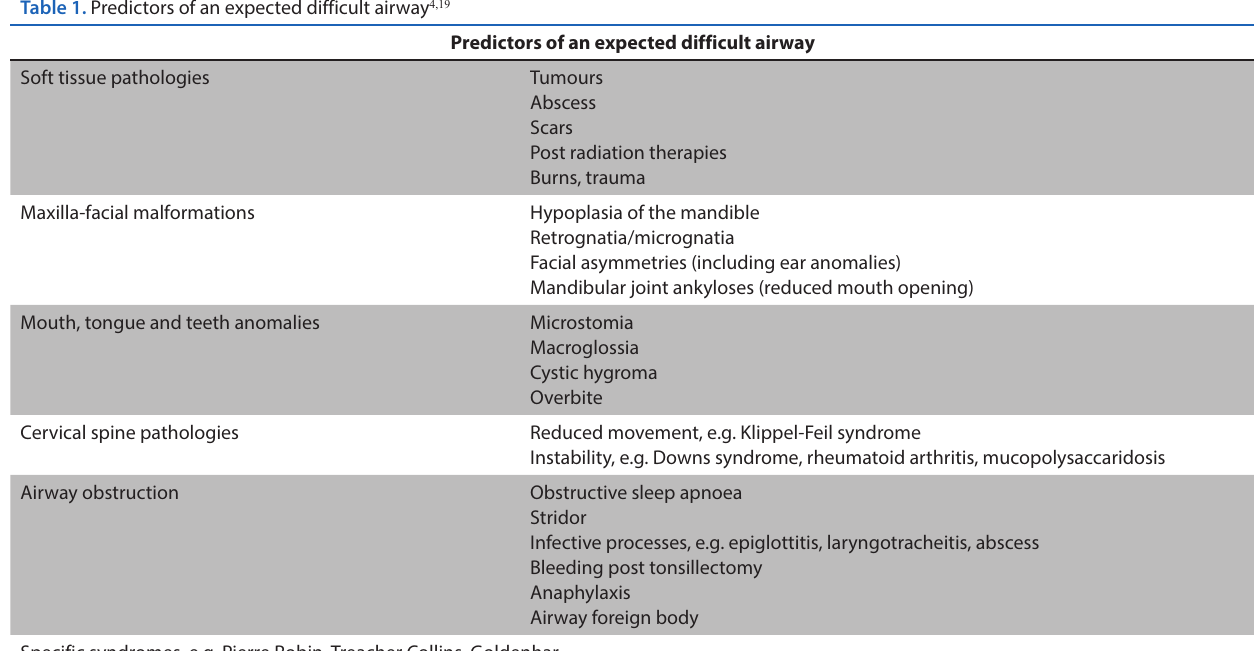
Table 1. Predictors of an expected difficult airway